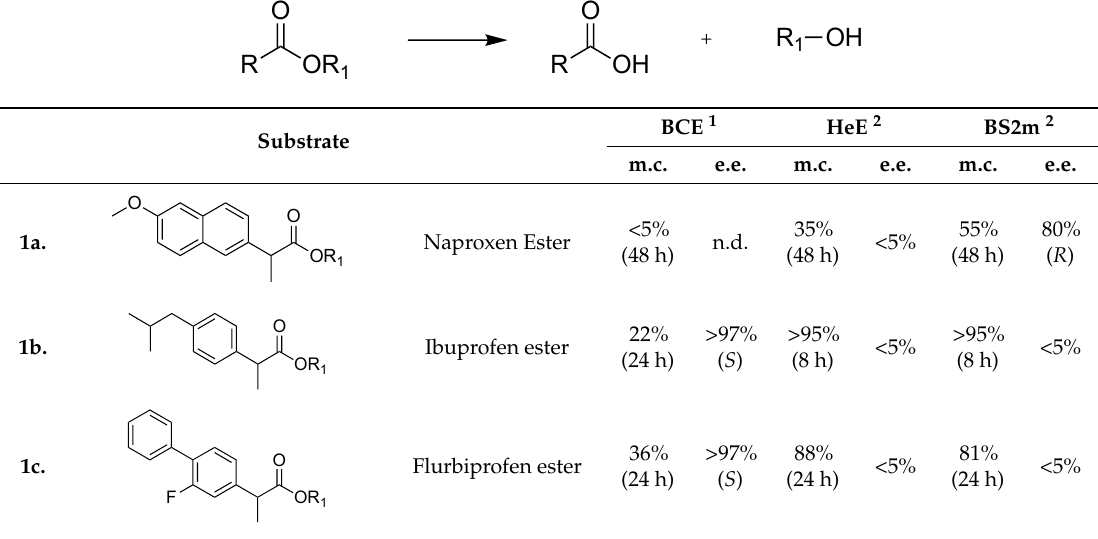
Table 1. Maximum molar conversion (m.c.) and enantiomeric excess (e.e.) of the batch biotransformations with all three enzymes and the substrates tested. A general scheme of the hydrolysis reaction is shown. For conversions <5% e.e. could not be detected (n.d). All enzymes were used at 0.1 mg/mL.